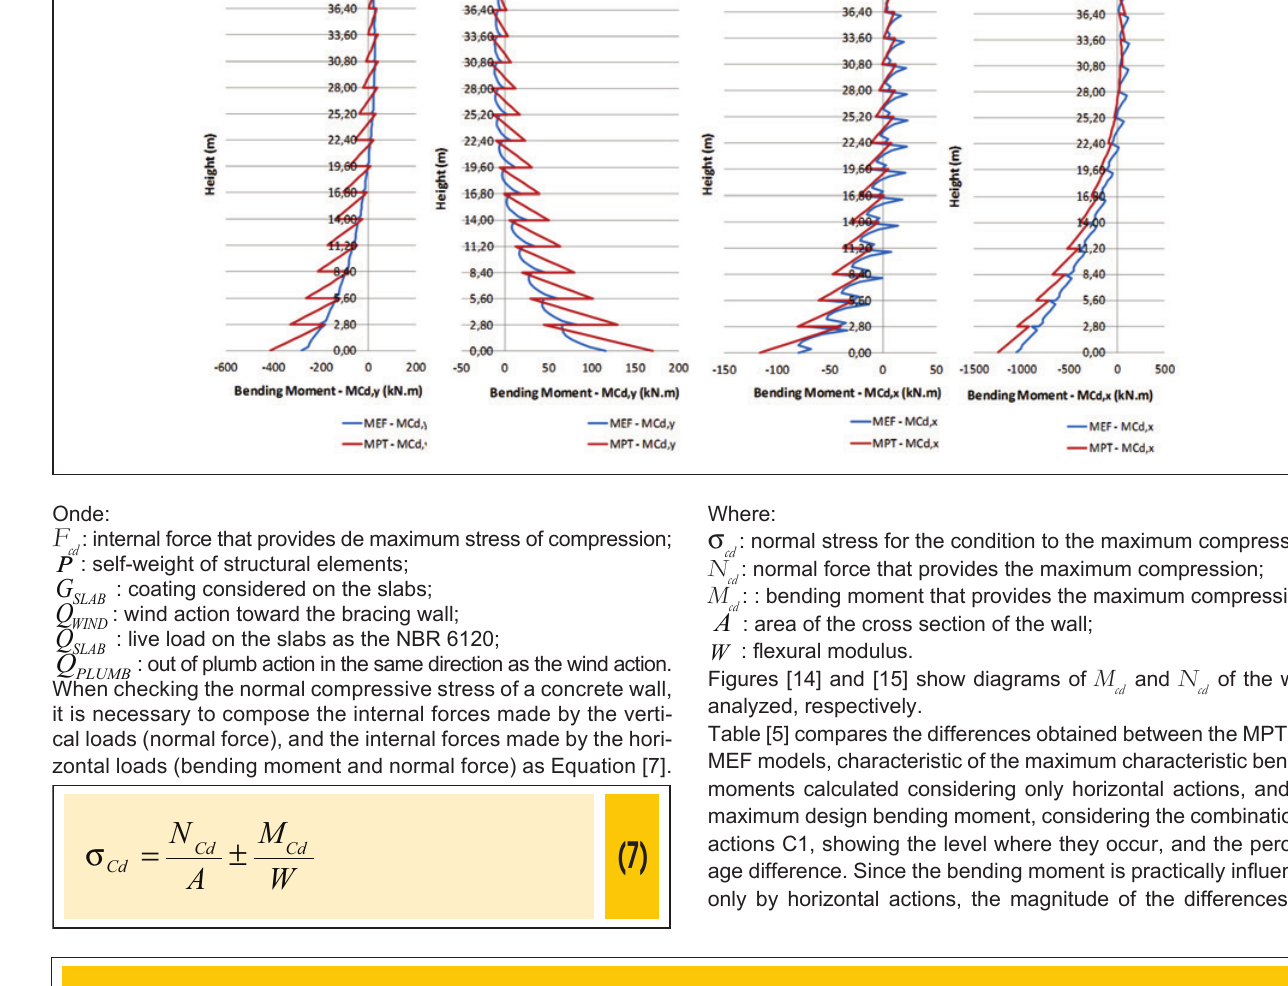
Figure 15 – Diagram of N of the walls PH16, PH34, PV08 and PV15